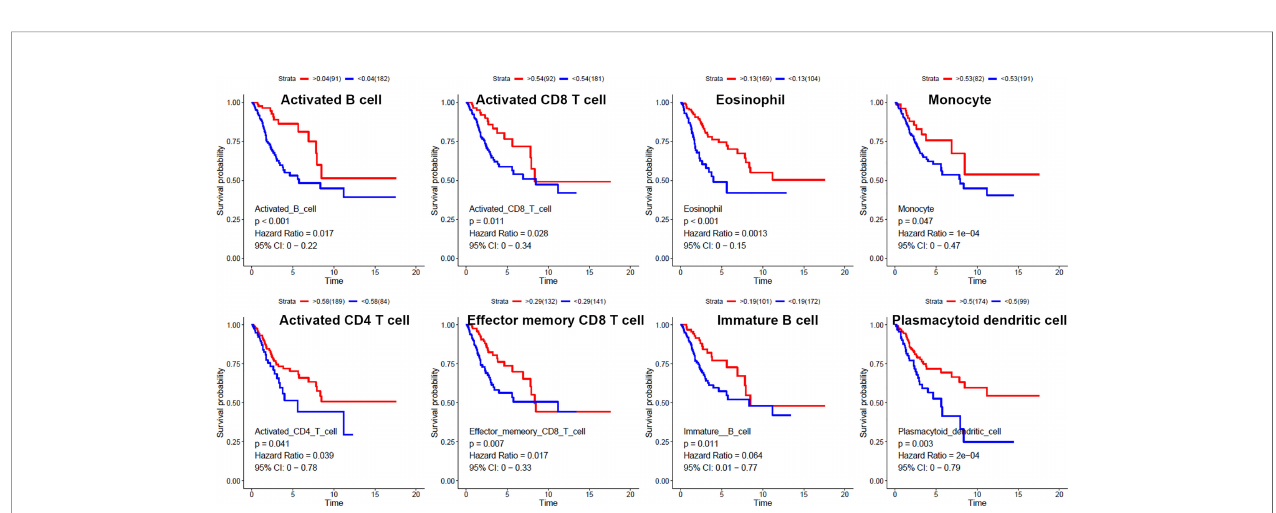
FIGURE 3 | Kaplan – Meier curves for overall survival of eight in fi ltrated immune cells. Activated B cell, activated CD8 T cell, eosinophil, monocyte, activated CD4 T cell, effector memory CD8 T cell, immature B cell, and plasmacytoid dendritic cell were associated with overall survival of cervical